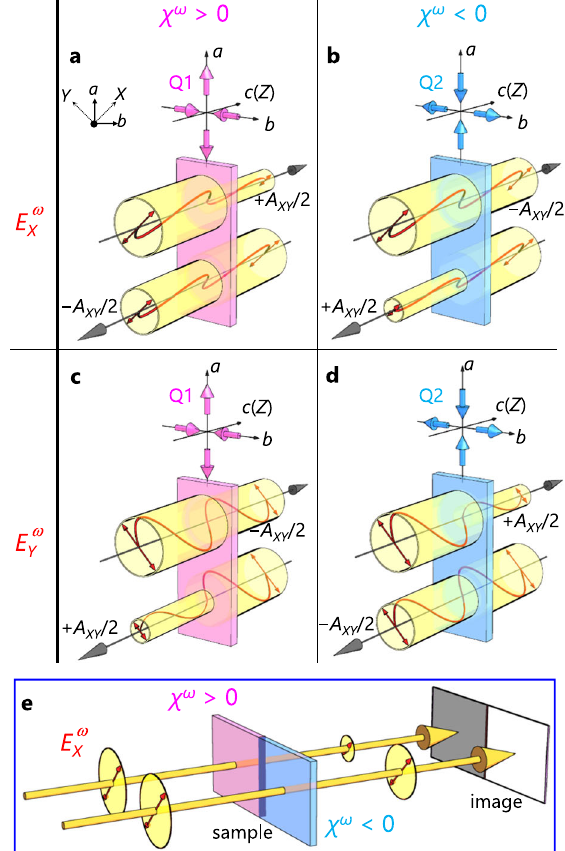
Fig. 1 Nonreciprocal light absorption induced by optical magnetoelectric (OME) effects. Optical absorption of the ab -( XY -) plane sample in various conditions in terms of the sign of the ME coef fi cient (± χ ), light propagation direction ( k jj ± Z ), and the polarization direction of the light ( E ω ). The length and orientation of the red double-headed arrows denote the intensity and the direction of E ω . The OME contribution to the absorption coef fi cient A is reversed between light with + k Z and − k Z (i.e., nonreciprocity) and between multipole domains with χ ω of opposite signs, as shown in a and b . The latter feature of the OME effects allows for the domain imaging of the ME multipole order by means of the optical microscopy, as illustrated in e . In particular case of the ME quadrupole ± q a 2 (cid:2) b 2 with ± χ ω XY ¼ ± χ ω YX , whose spin arrangement is represented by closed pink or light blue arrows, the OME contribution is further reversed by the light polarization switching between E ω X and E ω Y , as shown in a and c [ b and d ]. This phenomenon is called nonreciprocal linear dichroism. In this case, the OME contribution to A in all the panels is described only by the linear dichroism Δ A Δ A Y